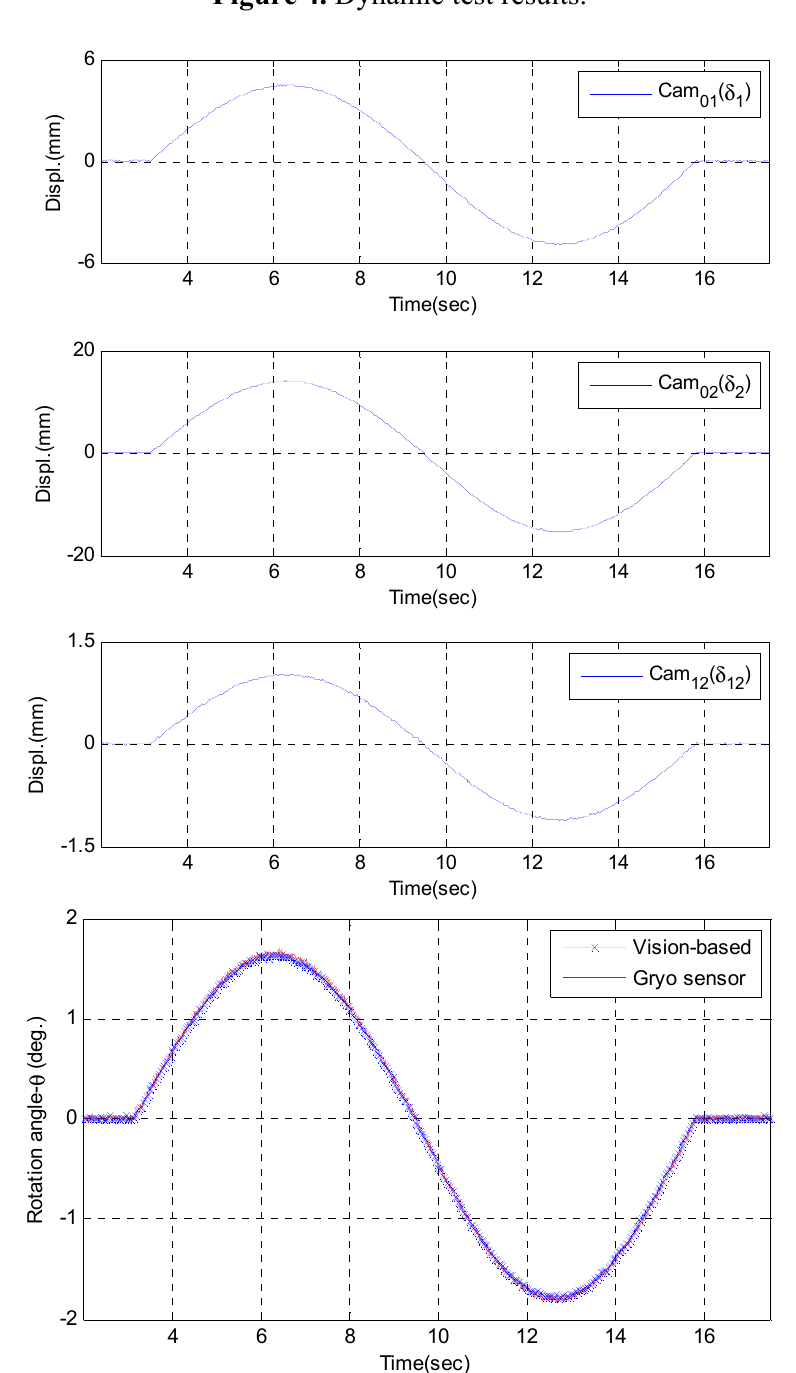
Figure 4. Dynamic test